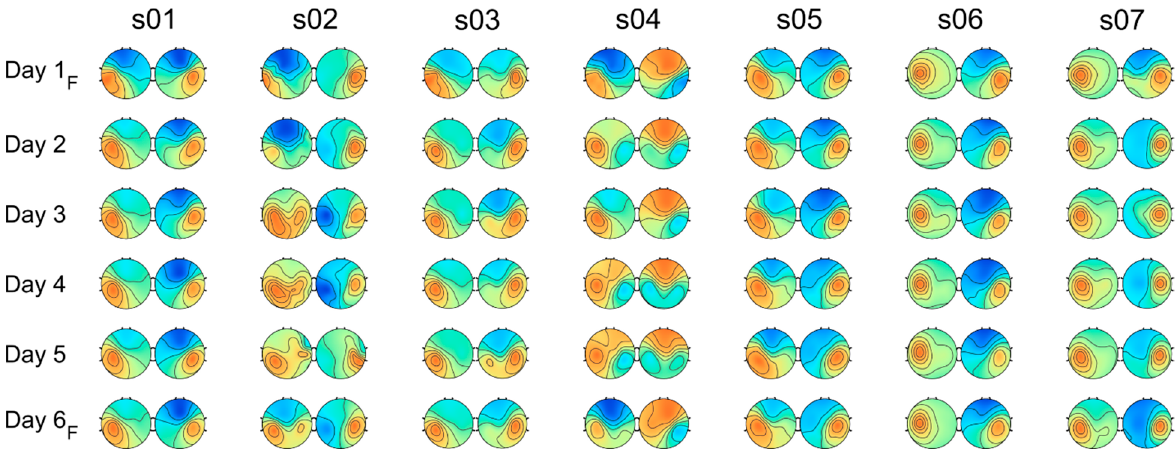
Figure 2. Forward models of the most significant SMR-ERD sources for motor imagery of right-hand fingers. For all subjects, contralateral and ipsilateral-dominant sensorimotor desynchronization sources were found and showed the largest desynchronization amplitudes. Colors correspond to the relative weights of EEG channels (red for positive and blue for negative weights; color scale is linear and symmetric). Spatial filters (eigenvectors) for corresponding components were sign-corrected to match directions across all six experimental days. For Days 1 and 6, models for feedbacked trials are shown (denoted by “F”).